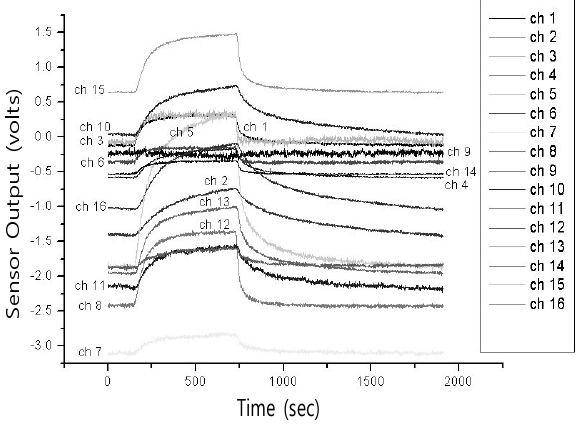
Figure 3. Typical time-responses of 16 channel sensor array with respect to inflow of acetone vapor at 5,000 ppm